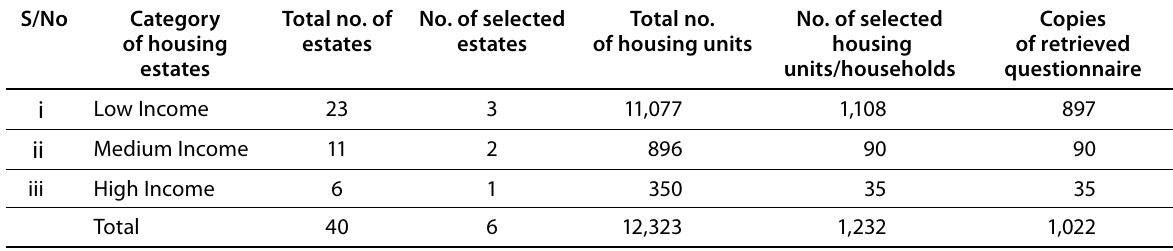
Total no. of No. of selected estates estates